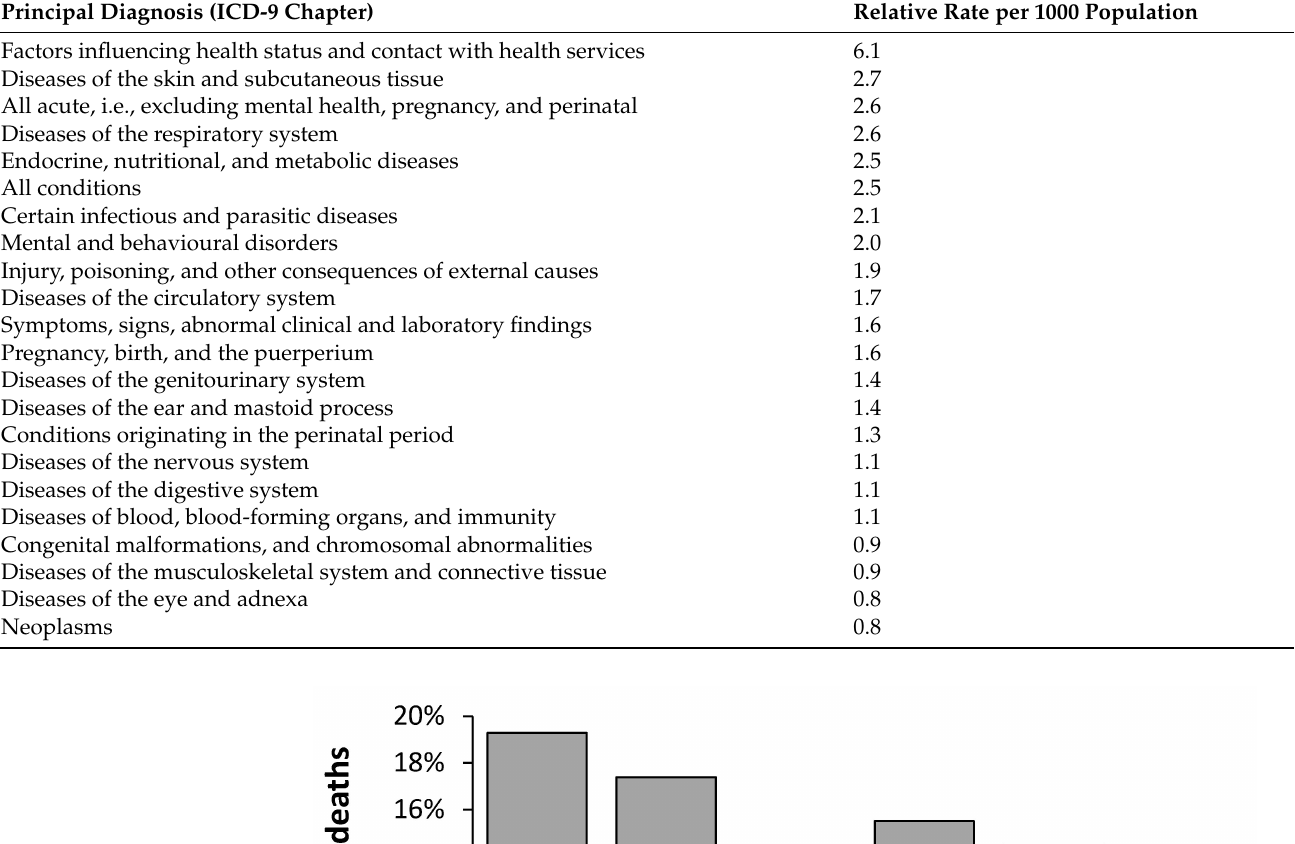
Table A2. Relative rates of admissions (separations) per 1000 population for Indigenous versus